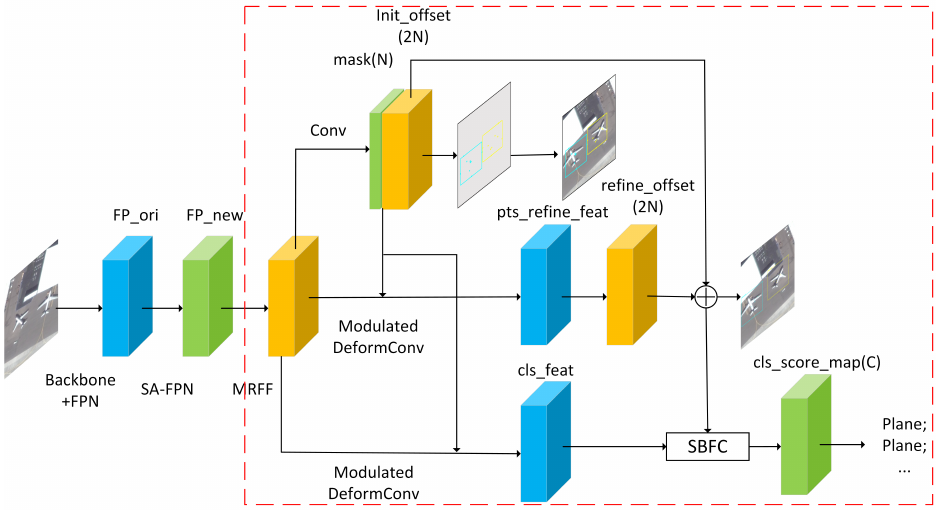
Figure 2. Overview of the AF-EMS detector. We only draw the detection head of one scale of FPN feature maps for clear illustration. In addition, all scales of FPN feature maps share the same afterwards network architecture (There are slight differences in SBFC module which we will explain in detail later) and the same model